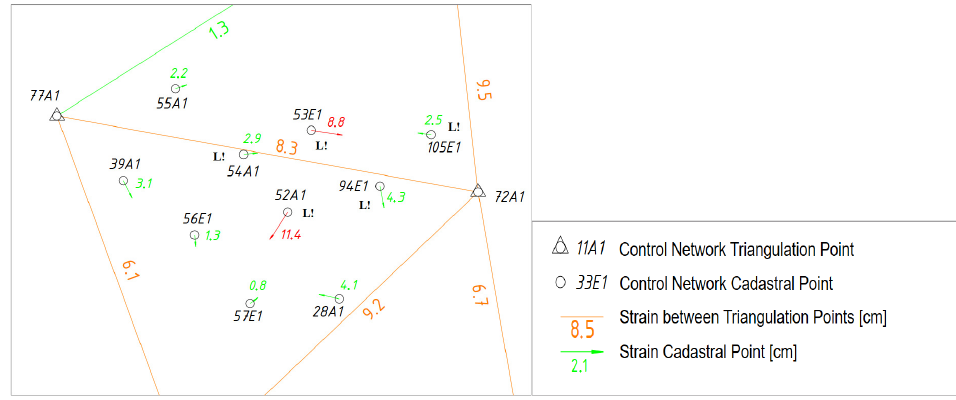
Figure 7. Distortion of the control points in Lachstadt. The red arrows show the direction and amount of distortion (data: